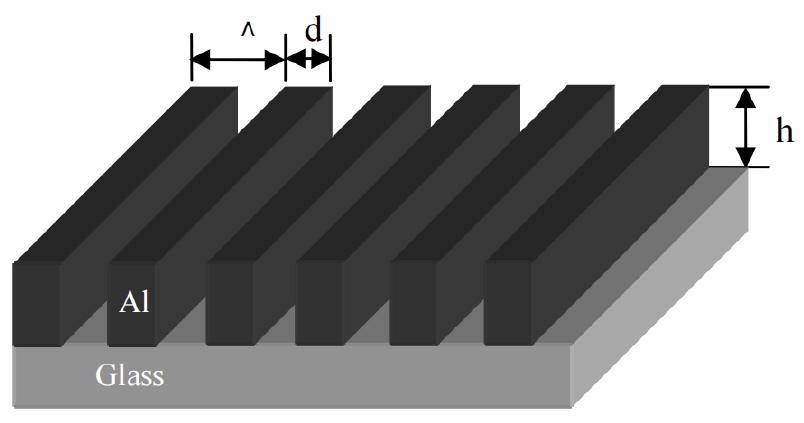
Figure 2. Structural model of subwavelength metal polarization grating.